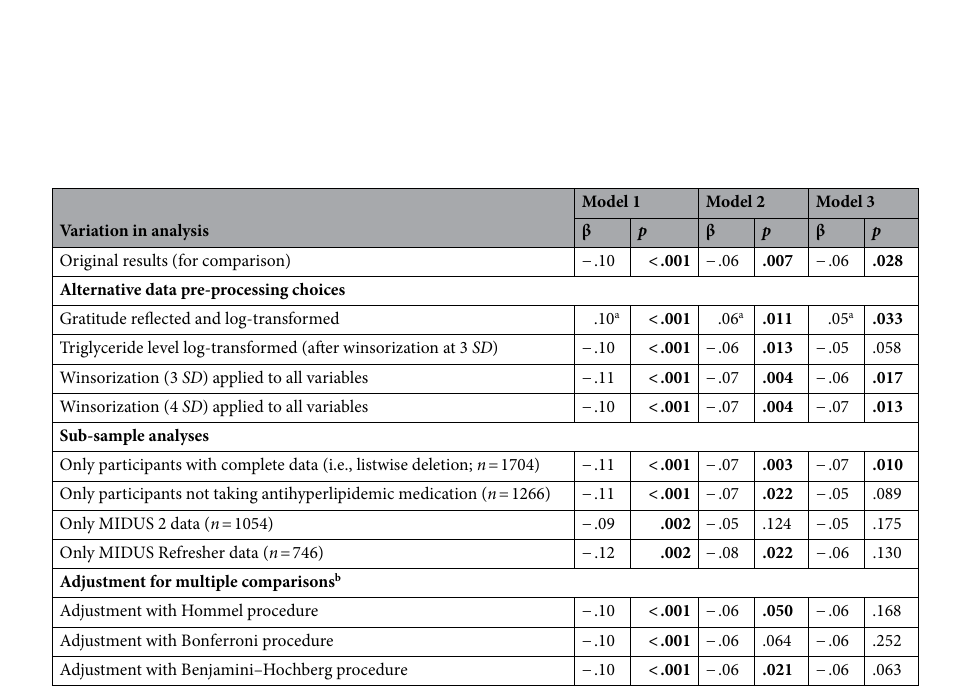
Table 5. Coefficients of gratitude predicting triglyceride levels in sensitivity analyses. Bolded p -values indicate statistical significance at the .05 level. a Coefficients were opposite in sign compared to the rest of the results because gratitude was reflected (i.e., reversed). b p -value adjustments were conducted taking into account all three dependent variables (triglycerides, LDL, HDL) across the first three models (i.e., a total of nine p